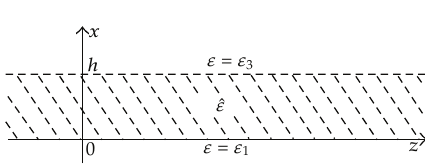
Figure 1: The geometry of the